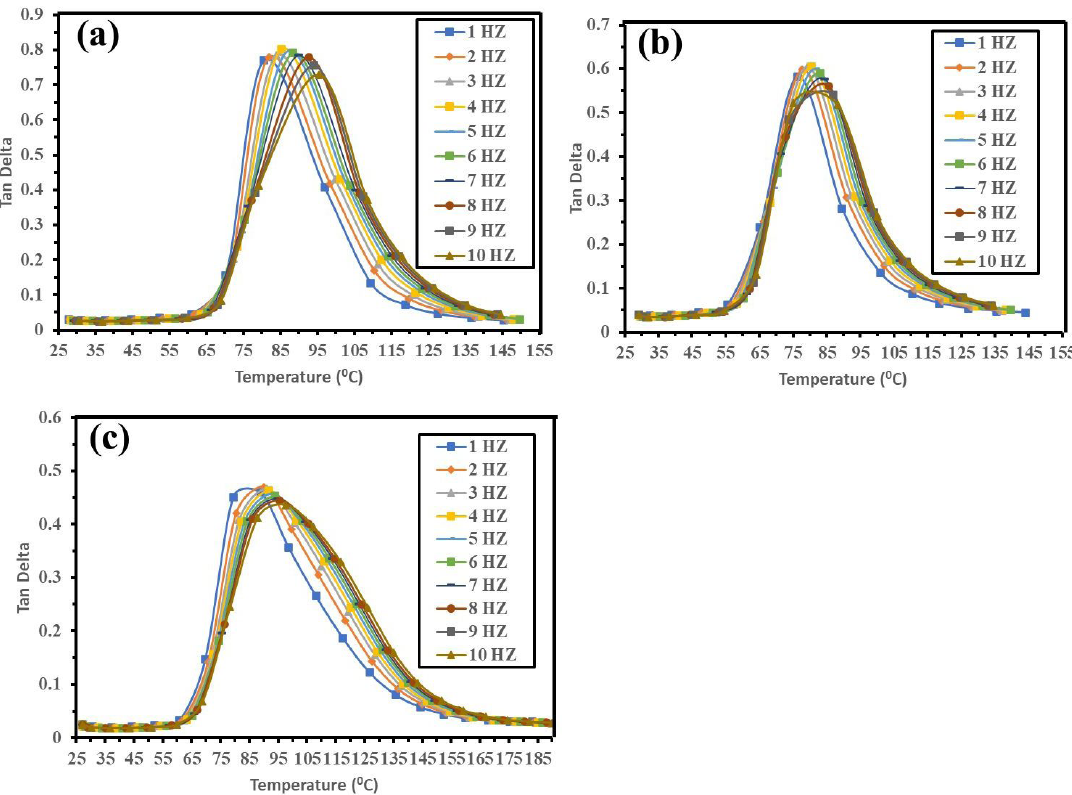
Figure 6. Tan delta curves: (a) EP2 composite, (b) EJP2, (c) EGP2 hybrid